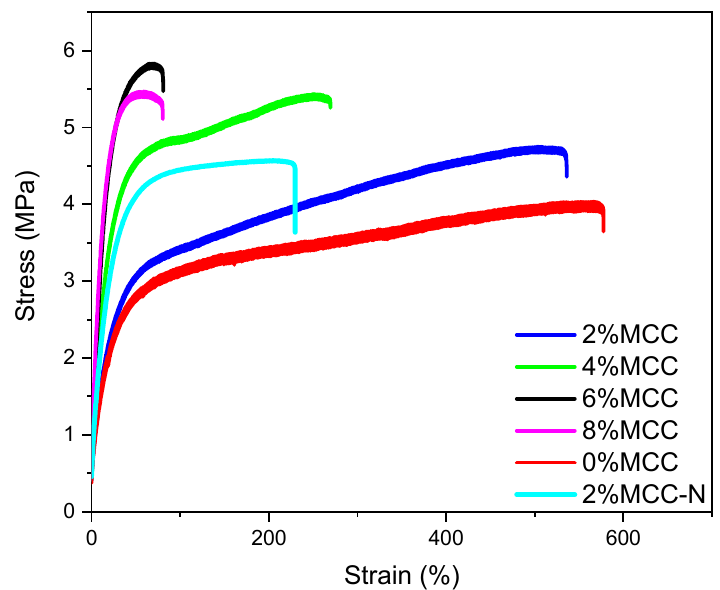
Figure 1. The stress to strain curves of typical film samples with different MCC content.